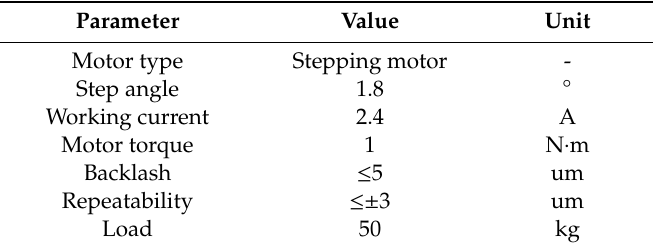
Table 5. The parameters of translational stages.